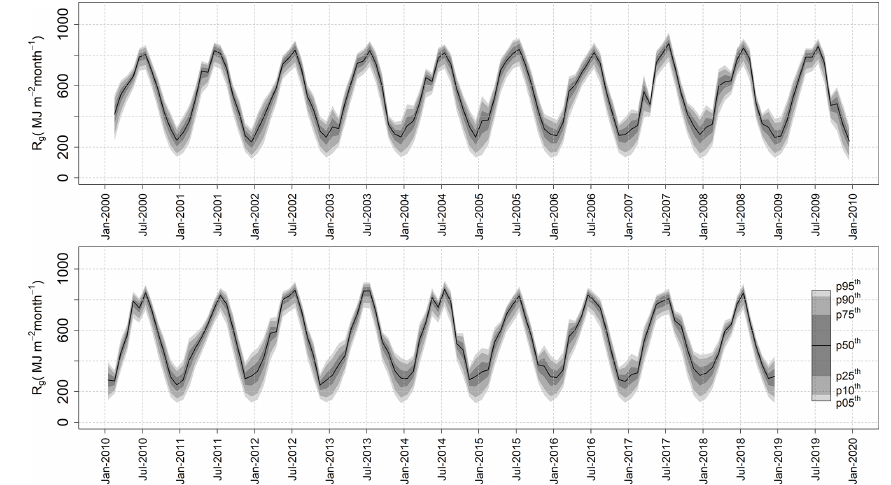
Figure 10. Evolution of the statistical distribution of monthly R g (MJm − 2 per month) in the study period (2001–2018) throughout the study area. Grayscale colors represent the following percentiles: 5th, 10th, 25th, 50th, 75th, 90th, and 95th.